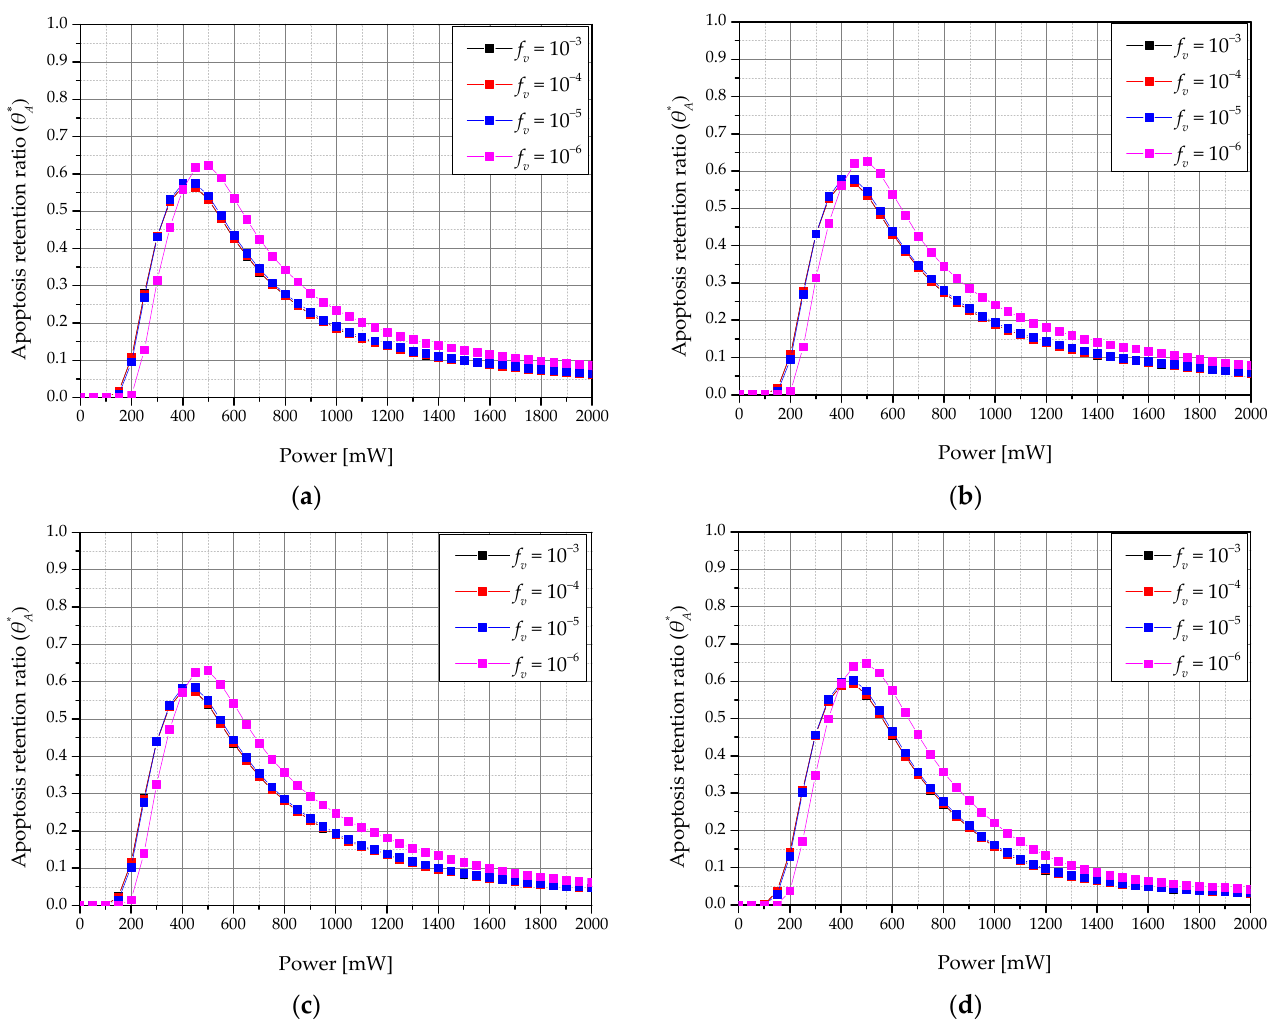
Figure 9. Apoptosis retention ratio ( θ ∗ ) for various volume fraction of GNR ( f v ) ( τ tot = 360 s) ( a ) τ h & τ c = 15 s; ( b ) τ h & τ c = 20 s; ( c ) τ h & τ c = 30 s; ( d ) τ h & τ c = 60 s.